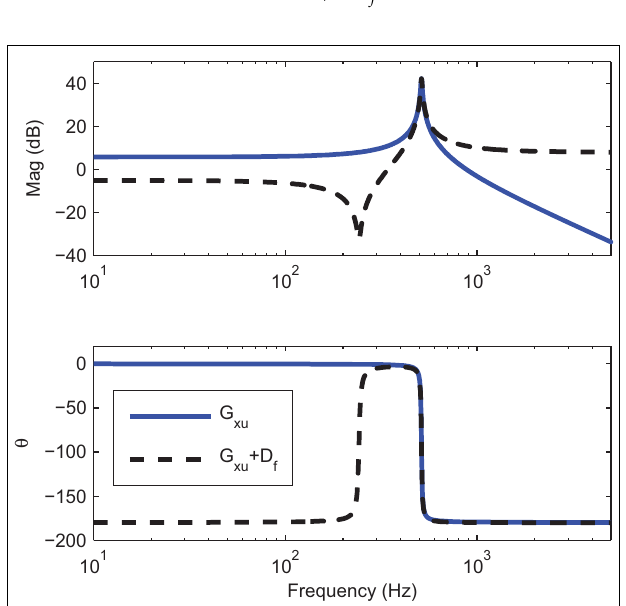
FIGURE 3 | Frequency response of the open-loop system G xu and with artificial feedthrough G xu + D f , where D f = (cid:0) 2.5 . The 180° phase change of G xu + D f is due to the negative feedthrough which also makes the system